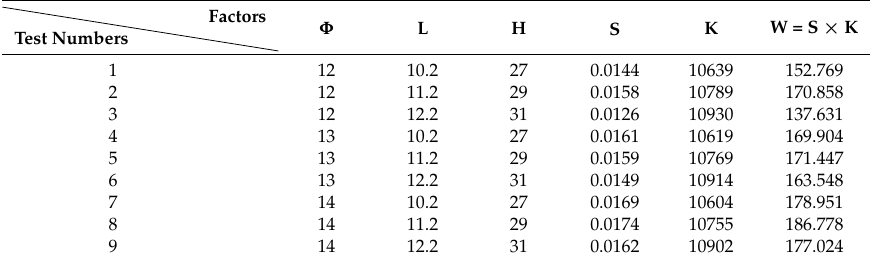
Table 1. Results of the orthogonal table.